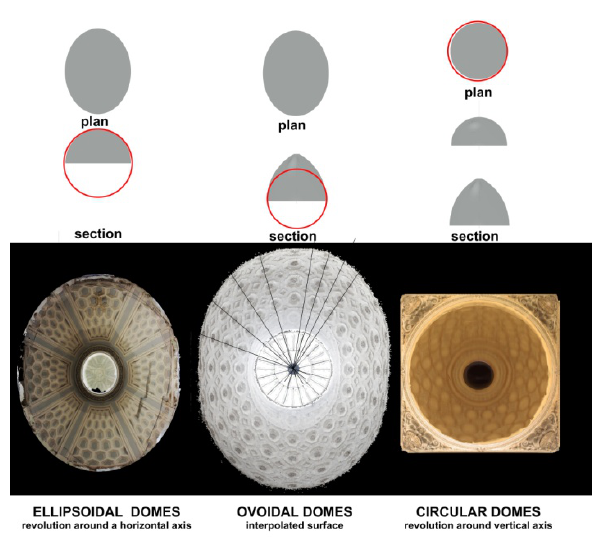
Figure 4. Domes geometry: classification